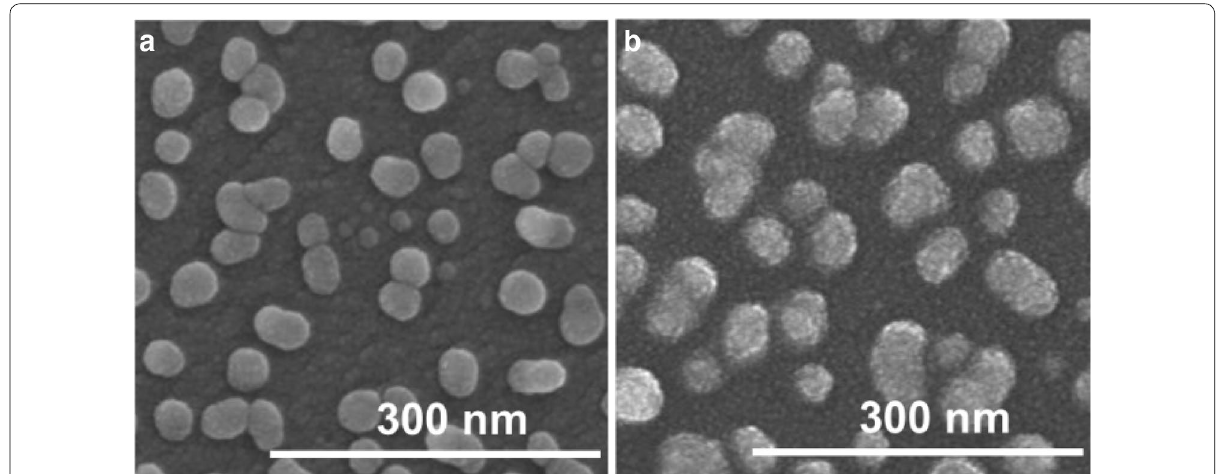
Fig. 2 The SEM images of Au NPs on the surface of the optical fiber a before and b after Au